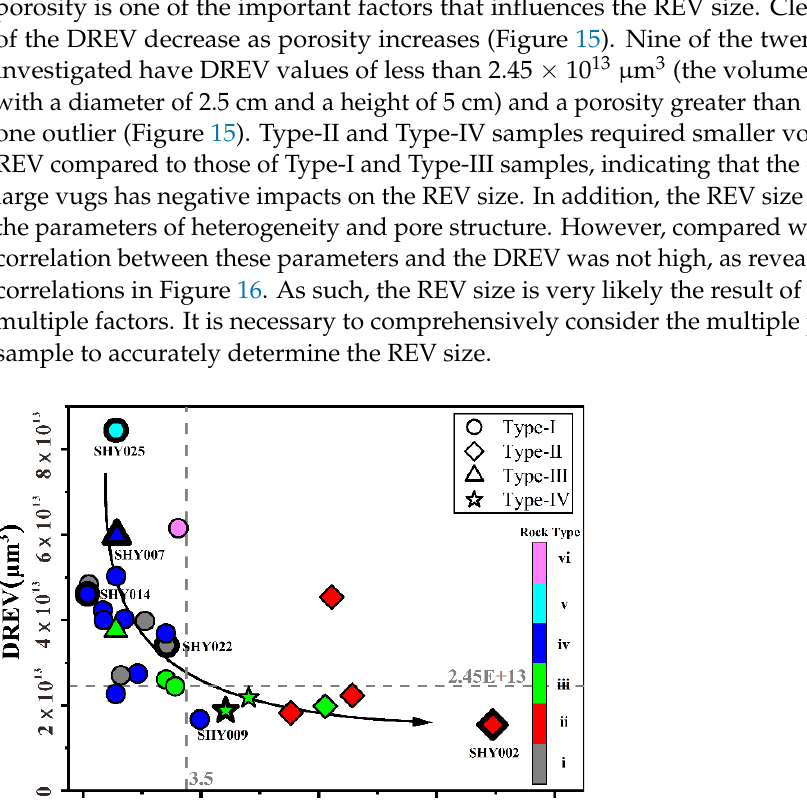
Figure 15. Cross ‐ plot of porosity and DREV with rock type superimposed in color. Marker shape Figure 15. Cross-plot of porosity and DREV with rock type superimposed in color. Marker shape represents pore type. represents pore